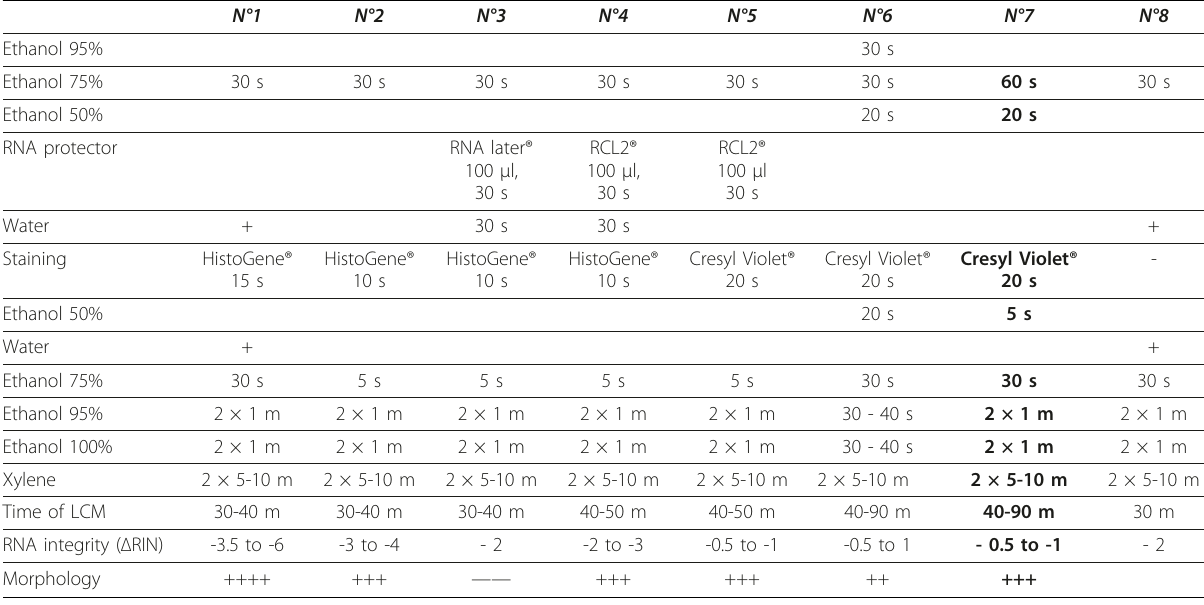
Table 1 Different protocols tested to optimize tissue section preparation before laser capture microdissection of mammary epithelial, yield and integrity of RNA extracted from microdissected